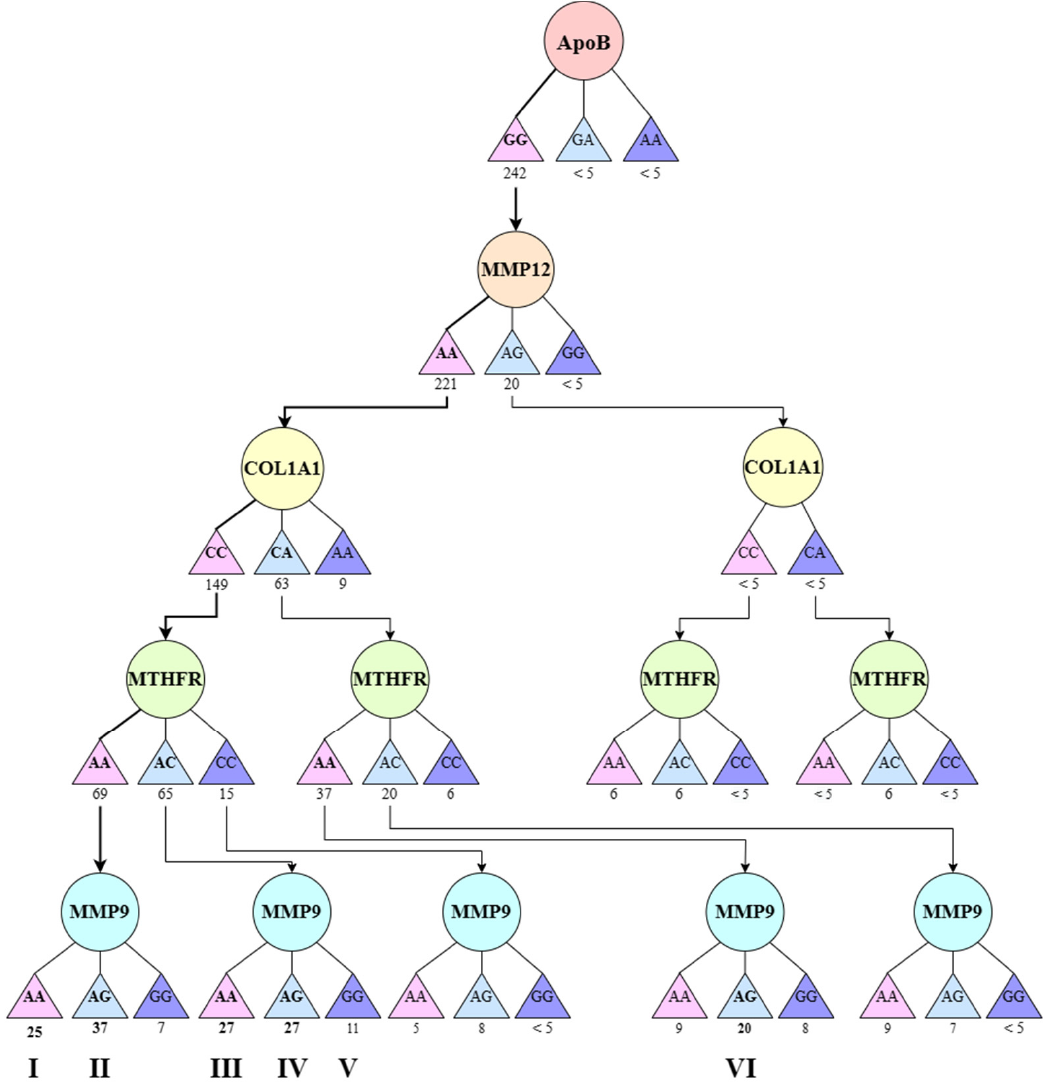
Figure 5. The distribution of study participants by clusters depending on the combination of geno- types in the population of residents of the Nizhny Novgorod region. A cluster was defined as a group of at least 10 participants.